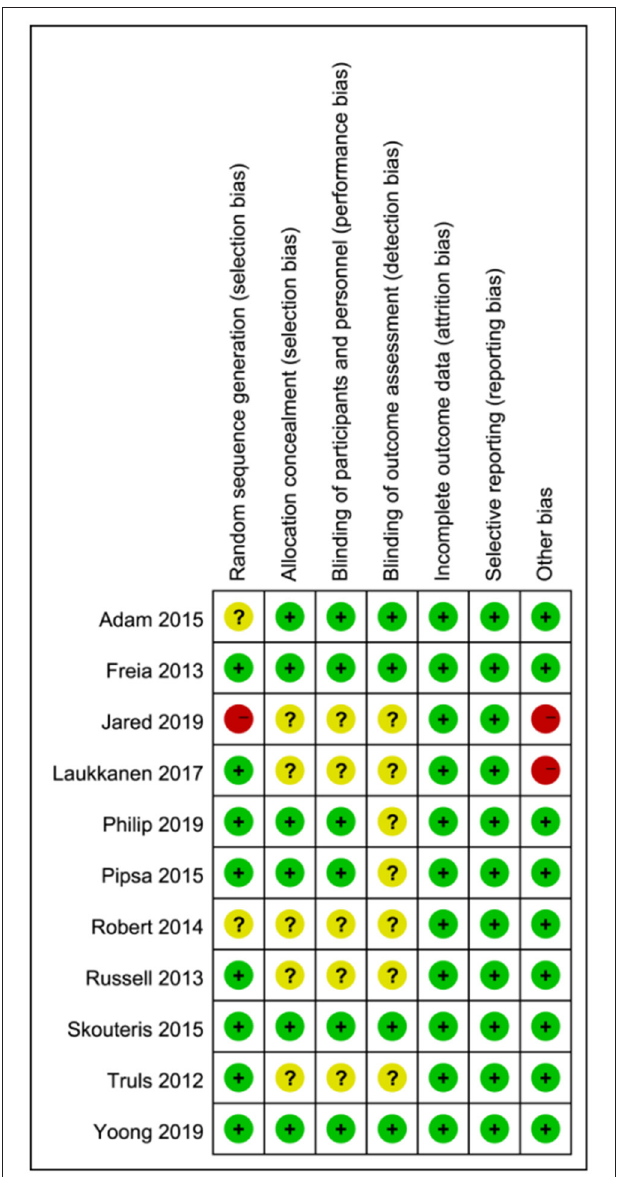
FIGURE 3 | Risk of bias of included studies. (Green unclear risk of bias; red =